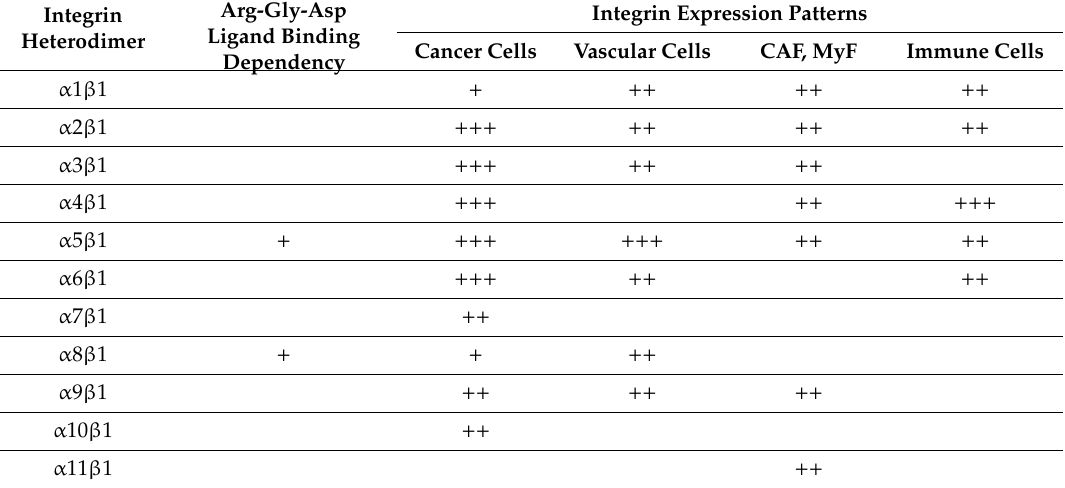
Table 1. Overview of integrins expressed in cancer cells and the cells of the tumor microenvironment. specific reviews and original articles [9,12,13,15–32]. Abbreviations: CAF, Cancer Associated Fibroblasts, MyF,